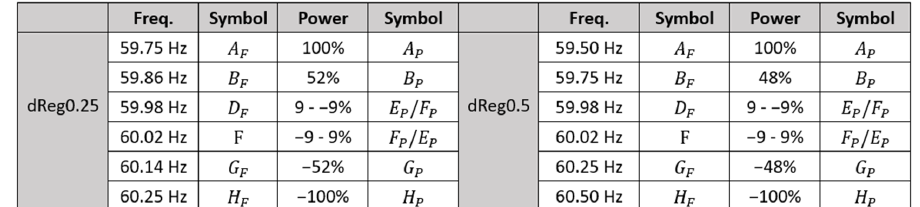
Figure 2. The response table of the dReg mode.